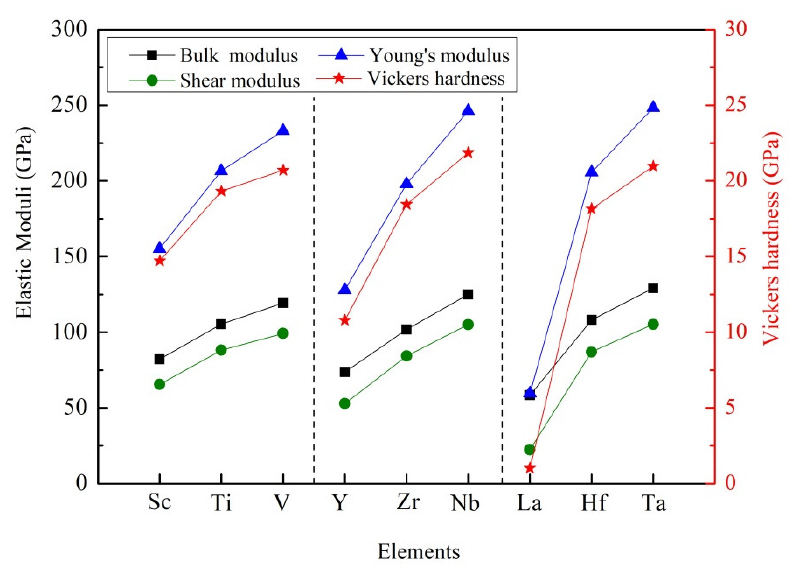
Figure 4. Comparison of moduli and Vickers hardness of different compounds.